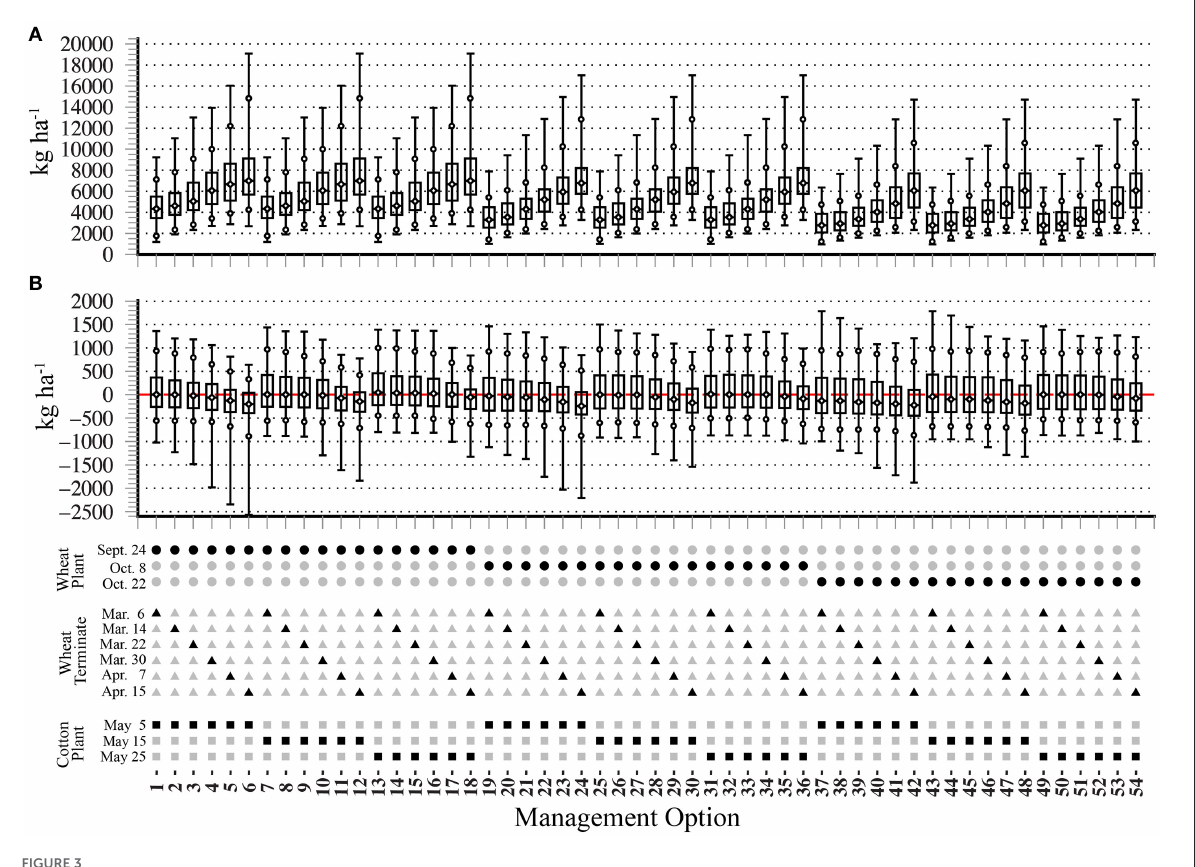
FIGURE3 (A) Distributions of wheat biomass at termination for each management option in the PSCL simulations. (B) Distributions of each management option’s WHCO minus FACO seed cotton yield effects in the PSCL